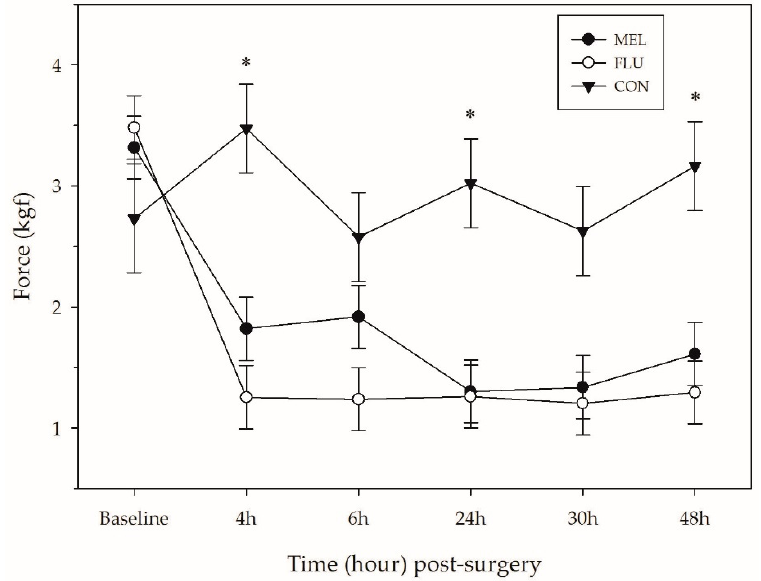
Figure 3. Mean mechanical nociceptive threshold (kgf ± SEM) around the abdominal incision for each treatment group over time ( n = 12 sheep per analgesia group; n = 6 controls). MEL = 2.0 mg/kg oral meloxicam pre-procedure and 1.0 mg/kg oral meloxicam at 24 and 48 h post-surgery; FLU = 2.2 mg/kg flunixin meglumine IV pre-procedure, at 24 and 48 h post-surgery; CON = non-surgical (control) group. Asterisk represents a significant difference ( p < 0.05) between the sheep who underwent a laparotomy (MEL + FLU; n = 24) and the CON